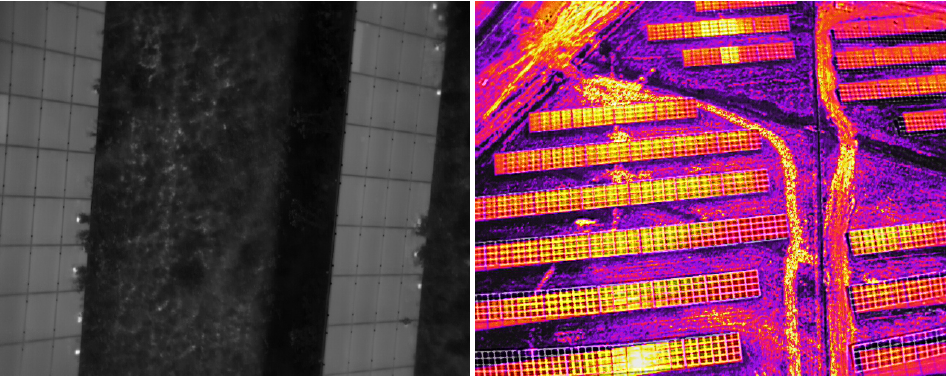
Figure 12. Two sample images from the database used in the experiments. On the left is a good quality image conforming to the [38] standard; on the right , there is a poor quality image: UAV was positioned too high.